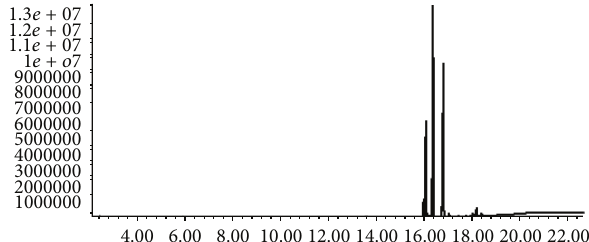
Figure 2: Total ion chromatography of urushiol methylene acetal by GC-MS.